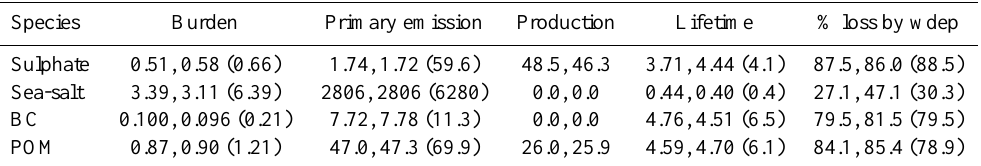
Table 2. Annual mean global mass burden (Tg), emission fluxes, secondary production fluxes (both Tgyr − 1 ) and lifetime (days) for each simulated aerosol component. Also shown is the % removal by wet deposition for each component. The values for the mode and bin versions of GLOMAP are shown before and after the comma, respectively. Values in parentheses are the median values simulated by AEROCOM models as documented in Textor et al.